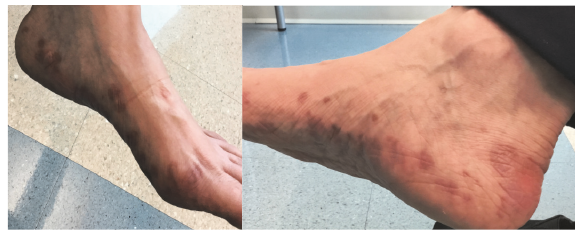
Figure 1: Photograph of lichen planus lesions on the patient’s feet.